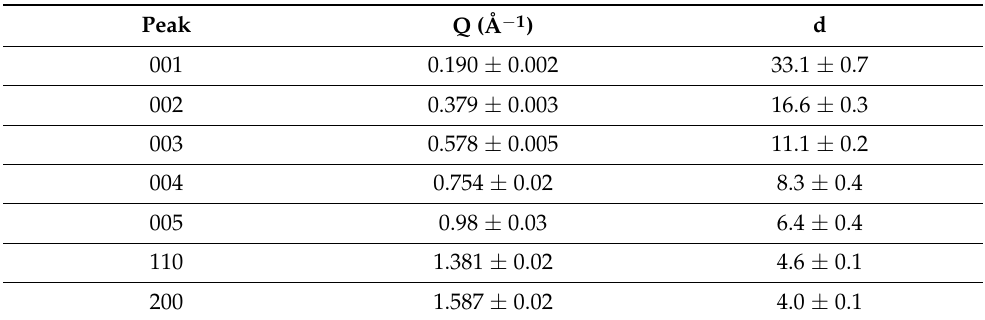
Figure 4. Proposed packing in the ‘’X” phase exhibited by CB8OFFFT : d is the layer spacing (32.9 Å), and a/b correspond to the lateral separations (4.0 Å and 4.6 Å). Table 2. Tabulated peak data from SAXS/WAXS of the ‘’X” phase of CB8OFFFT at a temperature of 74 ◦ C (T/T N-Iso =